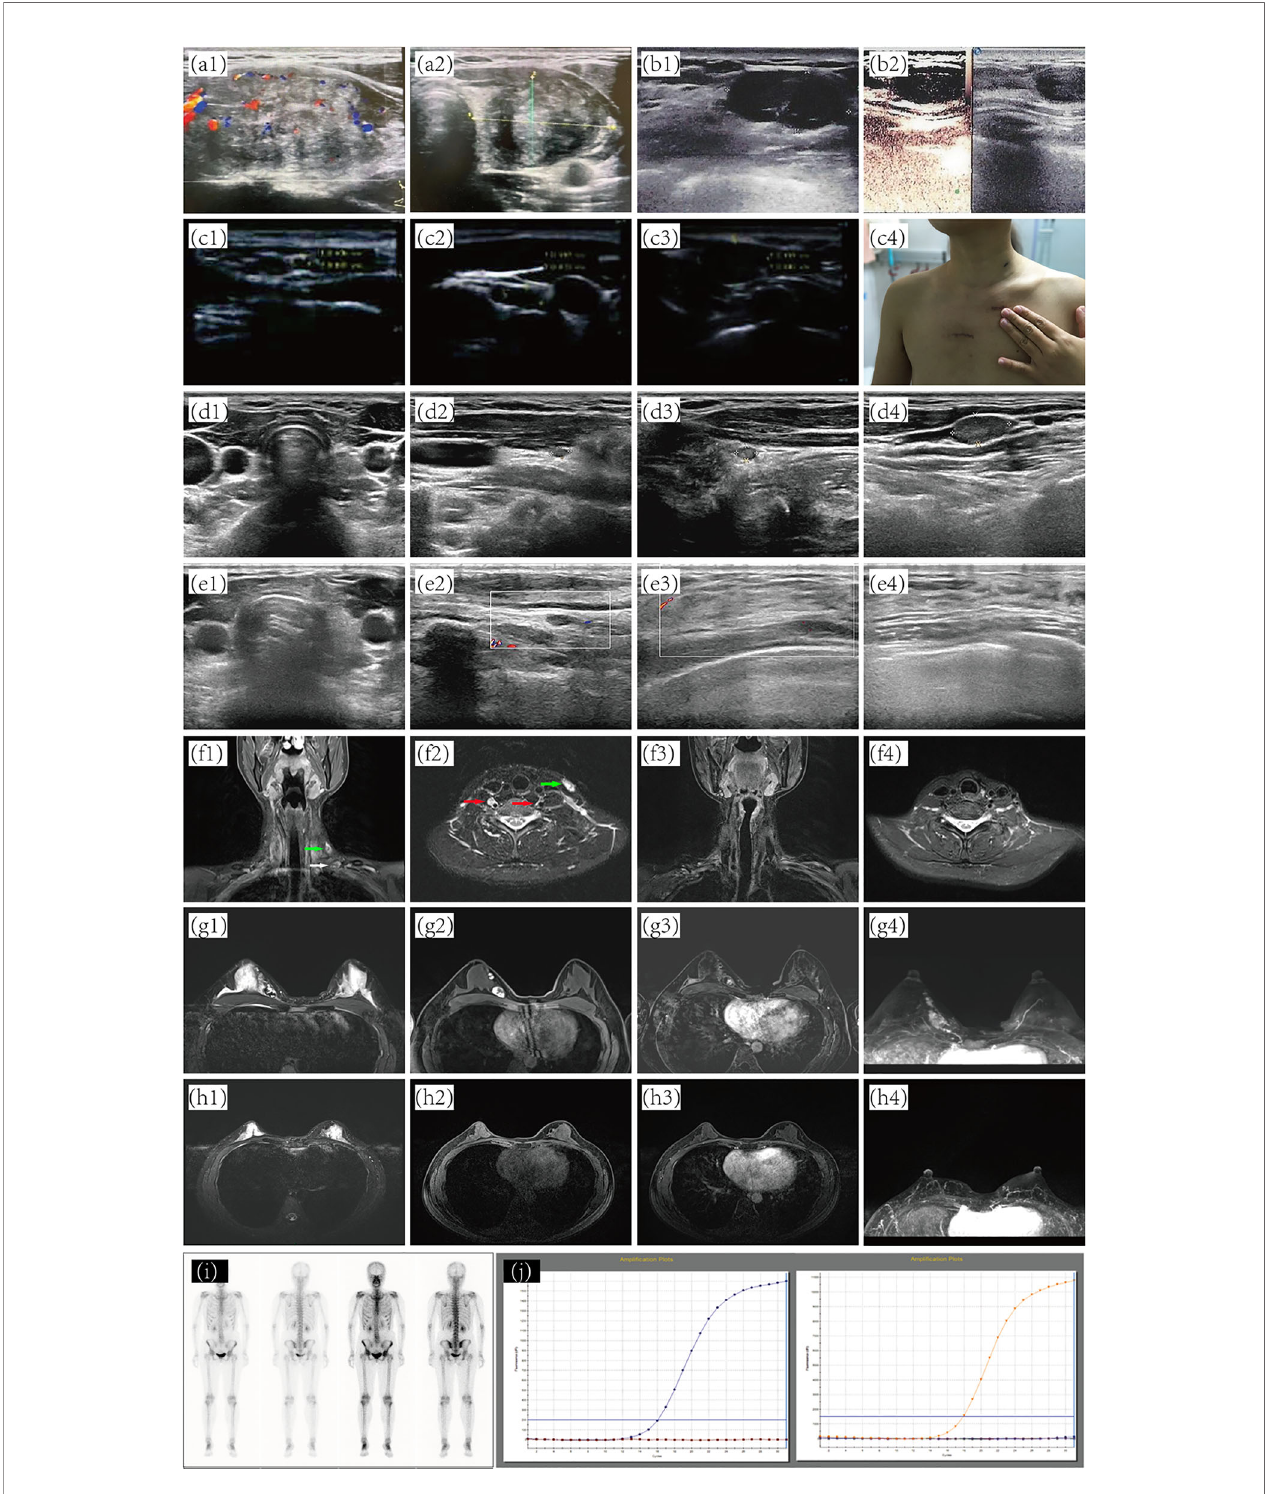
FIGURE 1 | Preoperative and postoperative imaging diagnosis. (A) preoperative thyroid sonography. (B) Subcutaneous nodules around the right areola of the breast. (C) separate nodules in the right chest wall. (D) Ultrasound assessment of thyroid and cervical lymph nodes after patient receiving ETC. Ultrasound of thyroid (E1, 2) and breast (E3, 4) at fi ve years post-operation. (F1, 2) metastatic lymph nodes. (F3, 4) No abnormality was found at fi ve years post-operation. (G) A predominantly cystic mass with solid portions. No abnormality was found on MRI (H) and 131 I-whole-body scan (I) at fi ve years post-operation. (J) NRAS, BRAF, and PIK3CA genes by quantitative real-time PCR. ETC, Endoscopic thyroidectomy; MRI, magnetic resonance